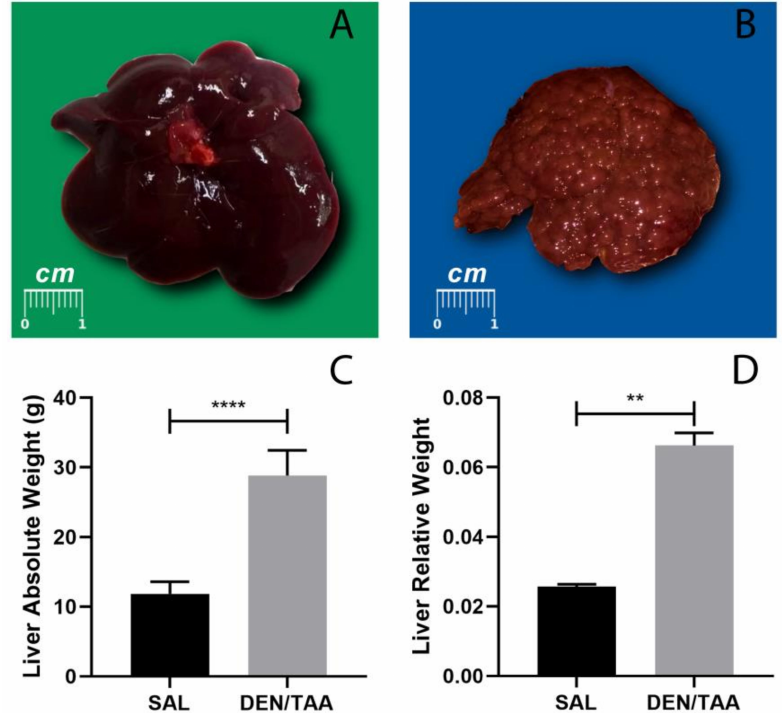
Figure 2. Representative images of macroscopic aspects of livers from ( A ) SAL-group animals and ( B ) DEN/TAA-group animals. Analyses of the absolute liver weight and relative liver weight are shown for ( C ) the SAL and ( D ) the DEN/TAA group. The relative liver weight (LW/BW) is expressed as the ratio between the liver weight (LW) and the body weight (BW). LW/BW ratio values are expressed as means ± sd; for the SAL and DEN/TAA groups, they were 0.25674 ± 0.000706 and 0.066253 ± 0.003554, respectively. (** p < 0.05) and (**** p <